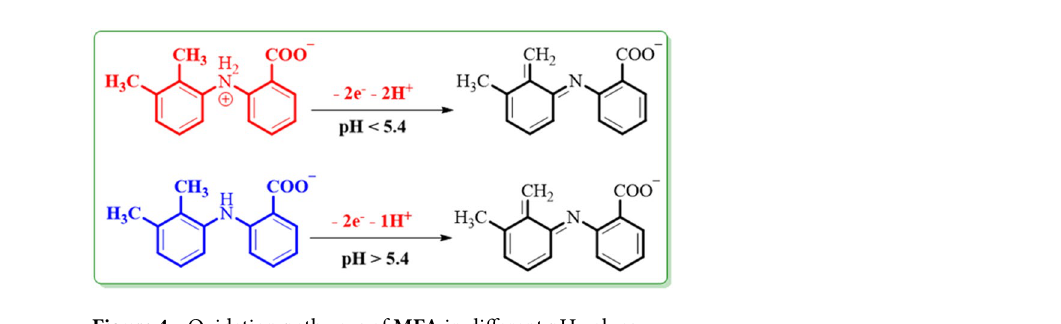
Figure 4. Oxidation pathways of MFA in different pH values.